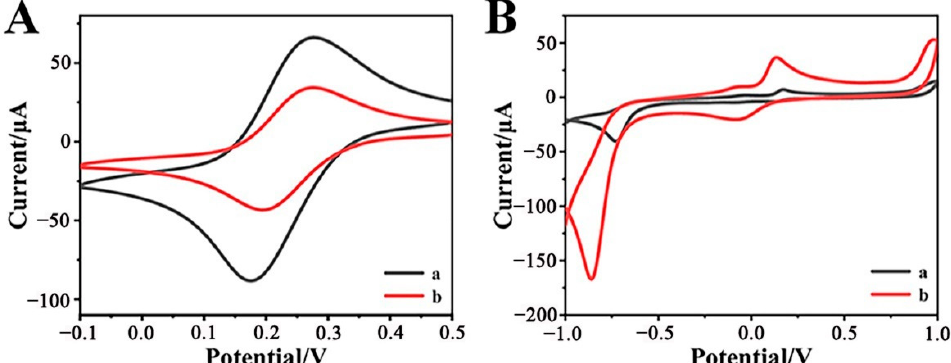
Figure 2. CVs of (a) bare GCE and (b) Cr-MOF/GCE electrodes in the solutions containing ( A ) 0.1 M KCl with 2 mM [Fe(CN) 6 ] 3-/4- and ( B ) 0.1 M phosphate buffer with 1 mM p-NP at the scan rate of 50 mV s -1 .